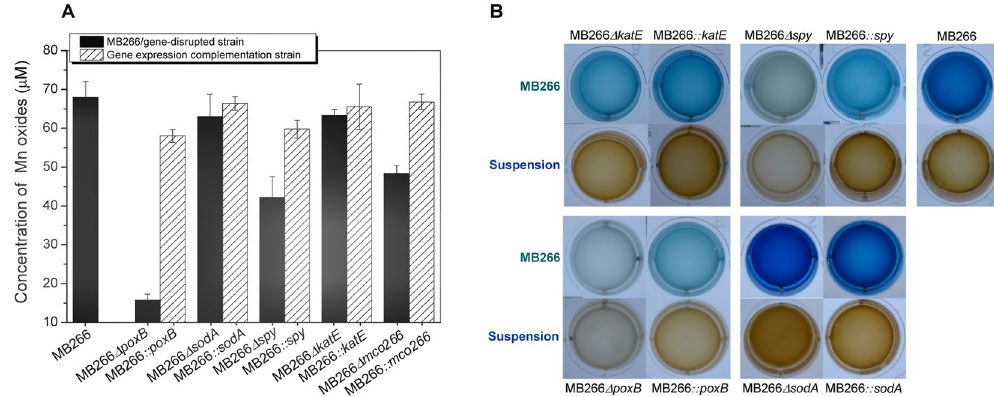
Figure 5. Measurement of Mn(II)-oxidizing activity in the gene disruption strains and corresponding complementation strains. Gene disruption and complementation strains of the key genes poxB , sodA , spy and katE were constructed. All the strains were grown in liquid Lept medium in the presence of 1 mM Mn(II) for 5 d. Subsequently, the Mn oxide concentrations of these strains were measured using the LBB method. The wild strain MB266 was used as a